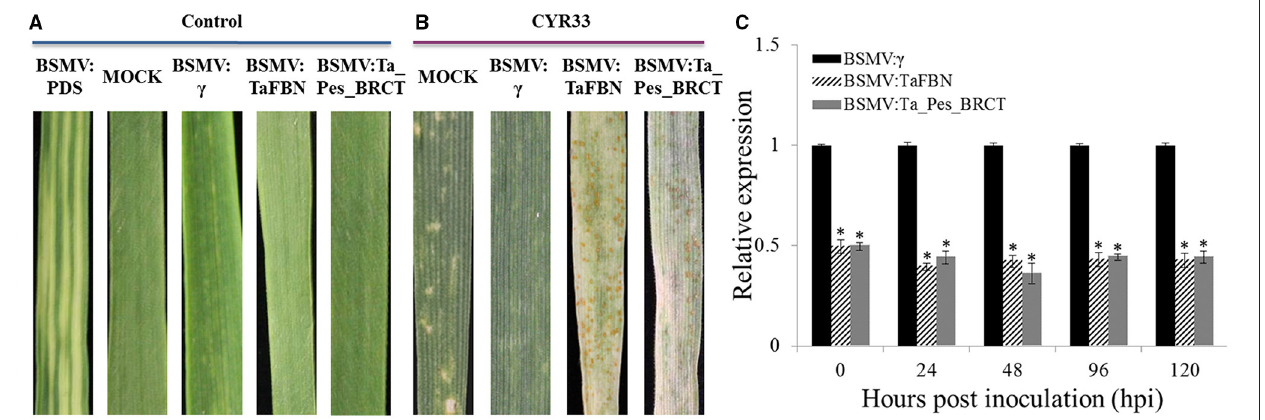
FIGURE 3 | Transient silencing of TaFBN and Ta_Pes_BRCT with the BSMV-VIGS method. (A) Wheat leaves treated with 1 × Fes buffer (MOCK) show no phenotypic changes. Mild chlorotic mosaic symptoms were detected on the plants inoculated with BSMV: γ , BSMV:PDS, BSMV:TaFBN, or BSMV:Ta_Pes_BRCT. (B) Phenotypes of the fourth leaves infected with uredospores of Pst race CYR33 at 10 days post inoculation. (C) Silencing efficiency assessment of TaFBN in the TaFBN-knockdown plants and Ta_Pes_BRCT in the Ta_Pes_BRCT-knockdown plants. Error bars represent the standard deviations of three independent samples. The significance of differences is indicated by asterisks and tested using Student’s t -test ( P <